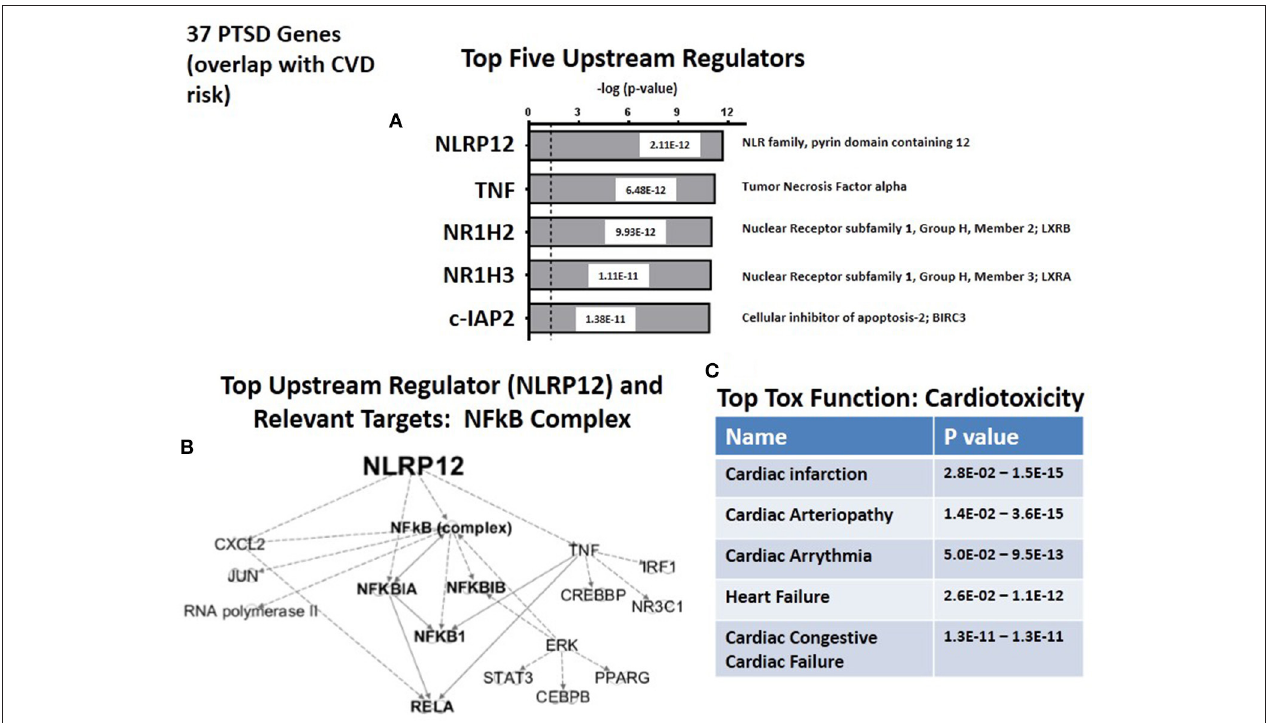
FIGURE 4 | Upstream regulation of risk genes for CVD. (A) Predicted Top upstream Regulators. The top two are NLRP12 and TNFa. (B) Predicted Targets of top two upstream regulator, NLRP12 and TNFa. (C) Predicted Top Tox (icology) Functions. All five describe cardiac